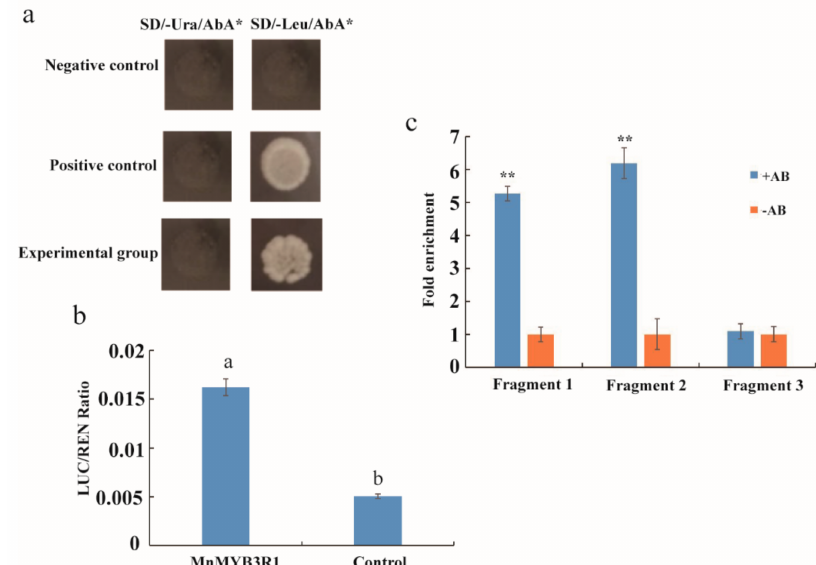
Figure 3. Verification of MnMYB3R1 binding to the MnPPO1 promoter region. ( a ) Yeast one-hybrid analysis; ( b ) LUC / REN ratio; ( c ) ChIP-qPCR analysis of the MnPPO1 promoter. Chromatin bound to MYB3R1 was collected by immunoprecipitation with ( + Ab) or without ( − Ab) an anti-MnMYB3R1 antibody. Fold enrichment of the promoter region was determined by normalizing the recovery rate against that of samples immunoprecipitated without the antibody. Fragment 1 is the MnPPO1 promoter region containing the MYB transcription factor-binding site and the MSA; fragment 2 is the MnPPO1 promoter region containing only the MSA; fragment 3 is the MnPPO1 promoter region without the MSA. Data are presented as the mean ± SD of three biological replicates. Significant di ff erences from the control immunoprecipitation without the antibody were determined based on the Student’s t -test (** P < 0.01). The experimental group represents Y1HGold (pAbAi-pPPO1 + MYB3R1) recombinant yeast; the negative control represents Y1HGold (pAbAi-pPPO1 mutation + MYB3R1) recombinant yeast; positive control represents Y1HGold (p53-AbAi + AD) recombinant